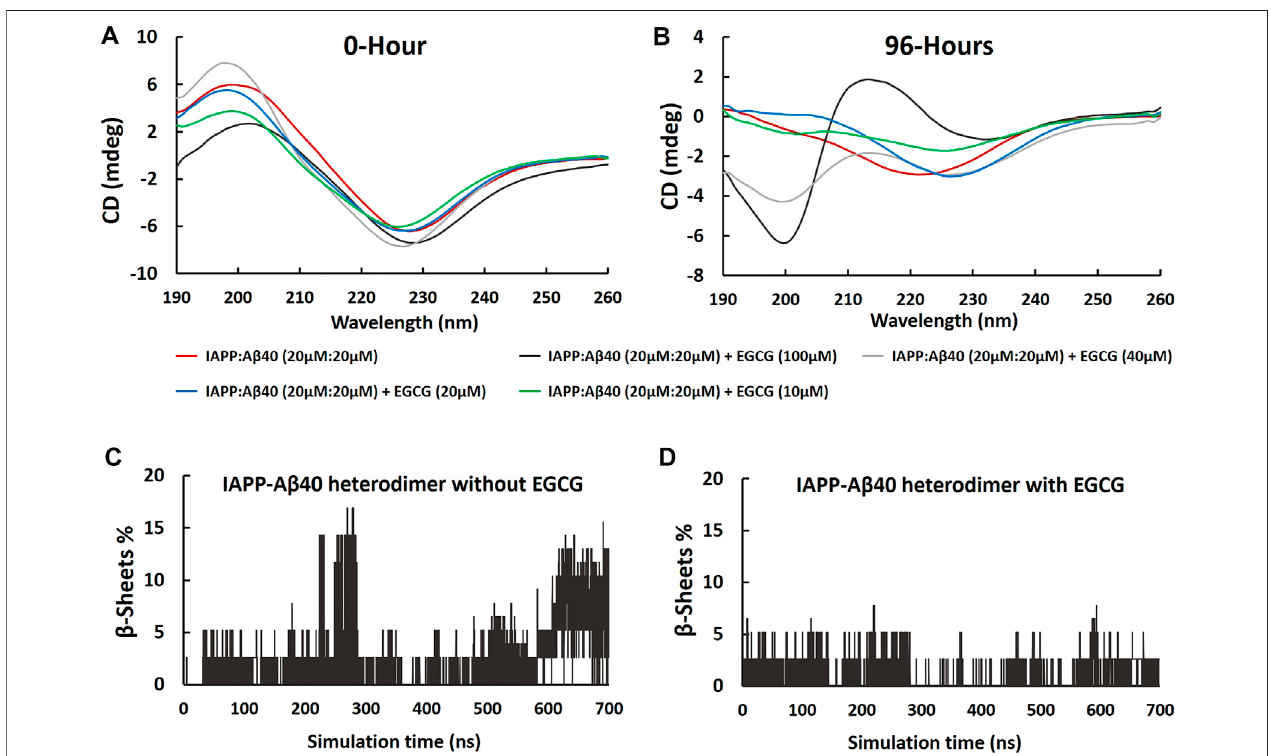
FIGURE 8 | Far-UV CD spectra of samples containing equimolar IAPP-A β 40 (20 µM:20 µM) in the absence and presence of increasing EGCG concentrations (10 – 100 µM) at (A) 0-Hour (fresh preparations) and (B) 96-Hours (aged aggregates). Percentages of residues forming β -sheets ( β -strands and β -bridges) in IAPP-A β 40 hetero-dimer, in the absence (C) and presence of EGCG (D) , were obtained using the 700 ns MD trajectories.